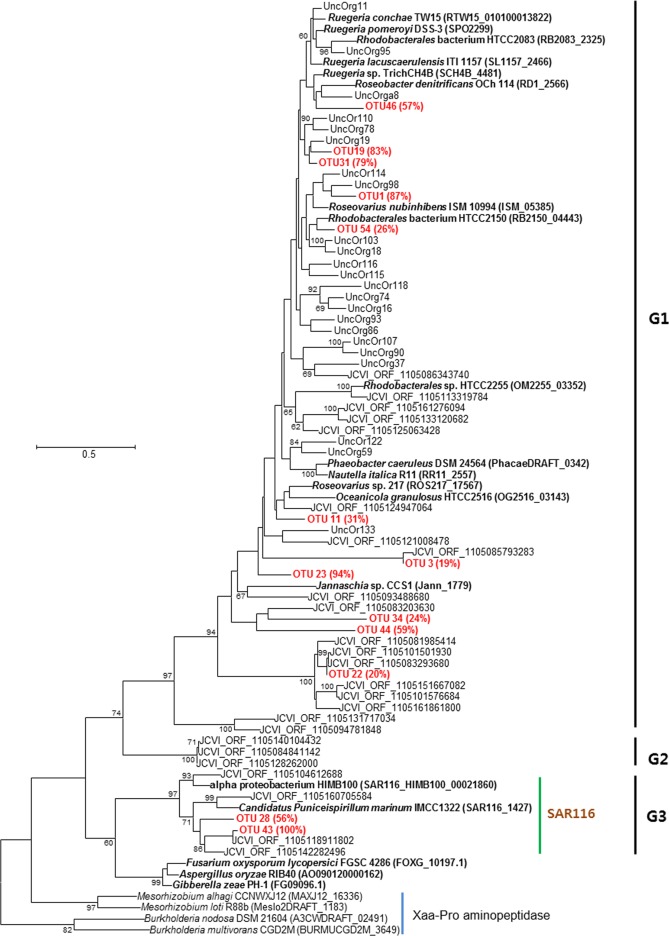
Tree showing the phylogentic relationships of representative amino acid sequences of each OTU obtained in this study (red text).Only OTUs constituting more than 10% of at least one sample are shown. The text in parentheses after bacterial names represent the locus tag for each genome in the IMG/ER database. The percentage in parentheses after OTU names represent maximum percentage of each OTU found in samples. Group names according to Todd et al. (2009) are shown on the right. A phylogentic tree for all OTUs can be found in S2 Fig. Only bootstrap values >60% are shown at the nodes.